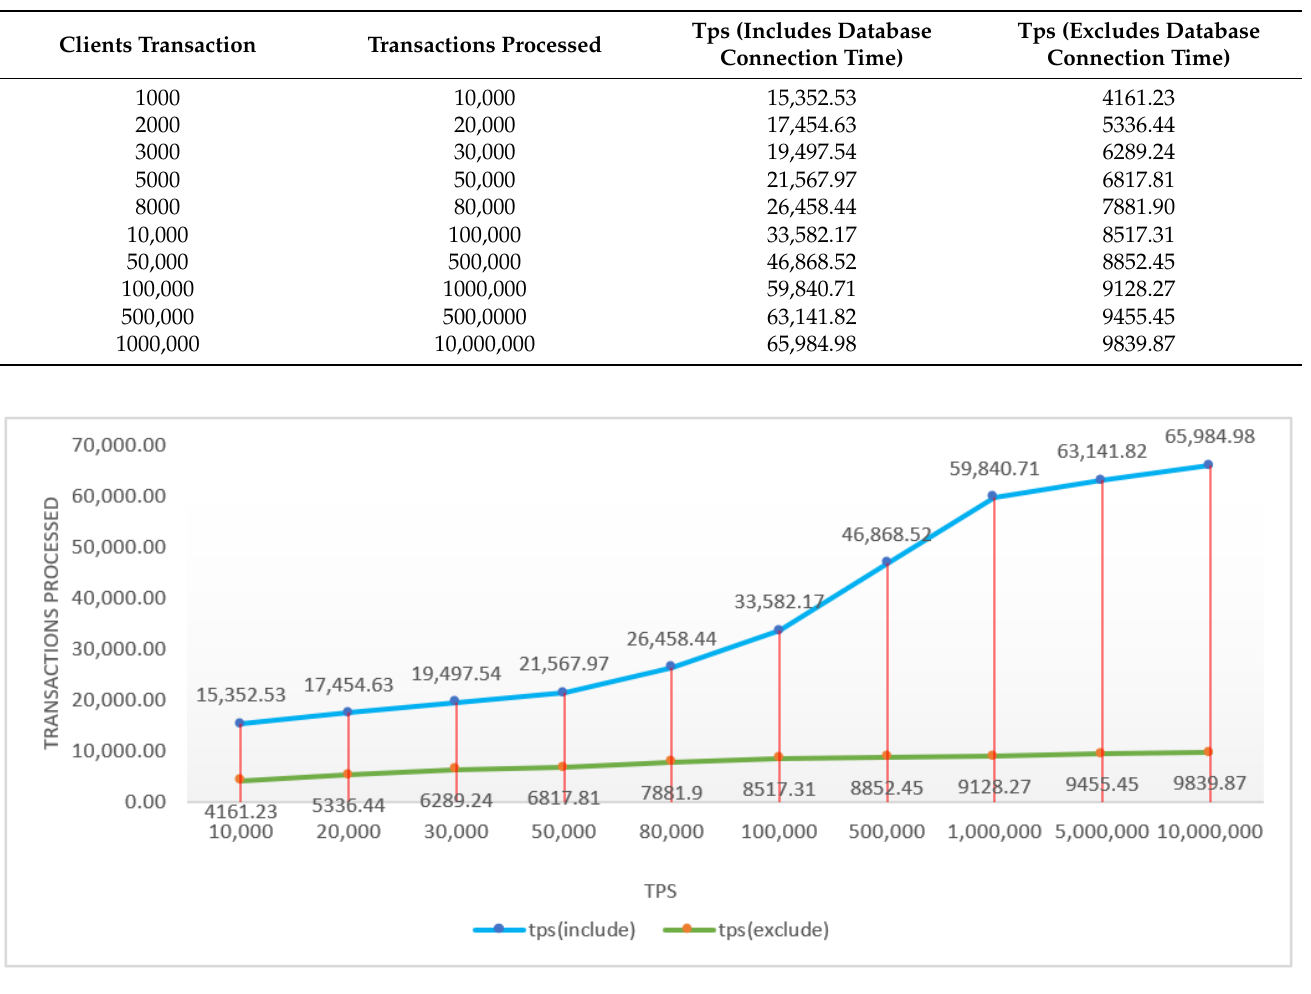
Figure 9. Graphical representation of the endurance of the database in relation to the processes initiated by the users. Table 3. Intensive testing of the database depends on the processes initiated by the users in rela- tion to the